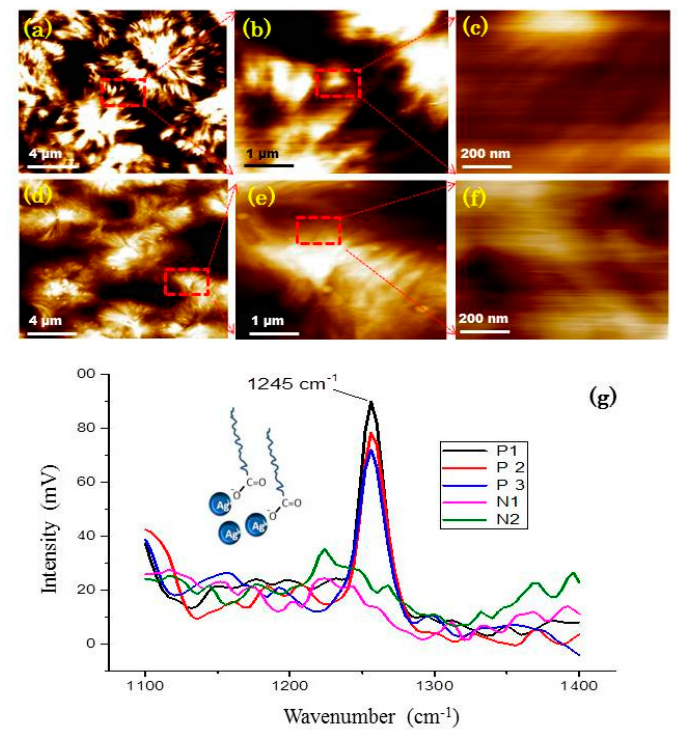
Figure 6. High-resolution AFM images of neat HDPE at different magnifications ( a – c ); high-resolution AFM images of morphology of HDPE/FeAg NPs nanocomposites ( d – f ) and IR spectra ( g ) of neat PE at position N1 and N2, the spectra of HDPE/FeAg NPs nanocomposites at different positions P1, P2, P3.